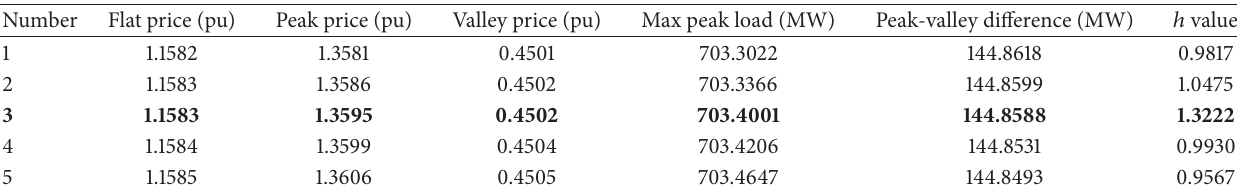
Table 4: A set of Pareto optimal solutions.